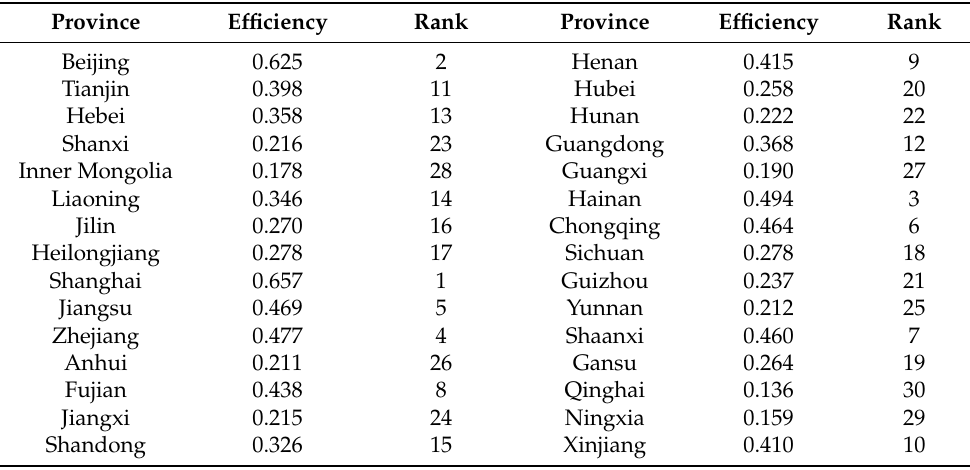
Table 2. Average agricultural water use efficiency in China from 2000 to